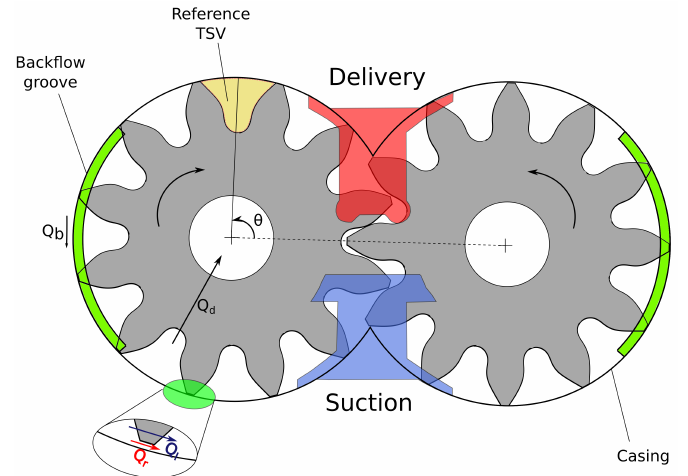
Figure 12. Simplified representation of the commercial EGM unit. The flow through the backflow groove, radial and lateral gaps are denoted, respectively, by Q b , Q r and Q l .